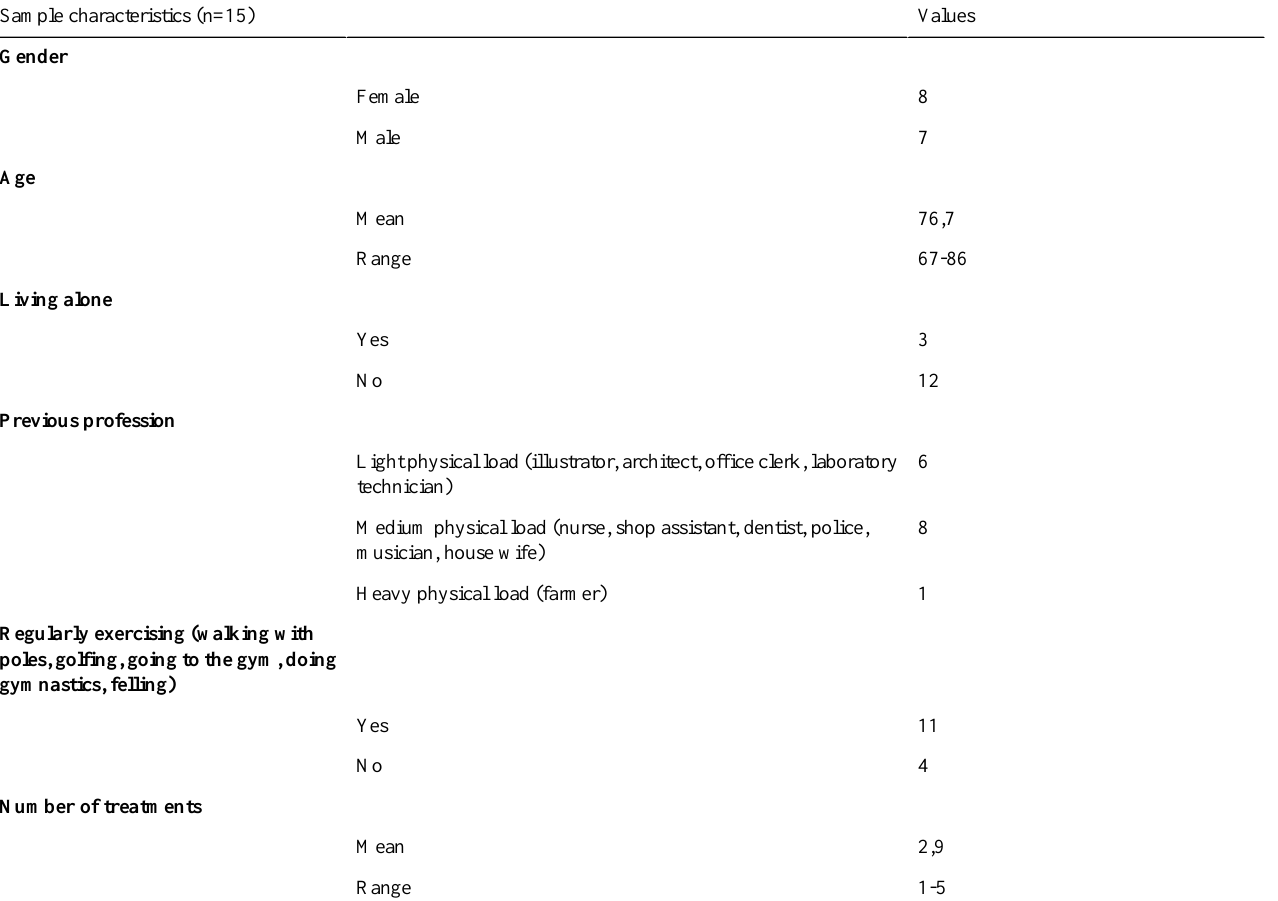
Table 1. Demographics of the study participants or sample